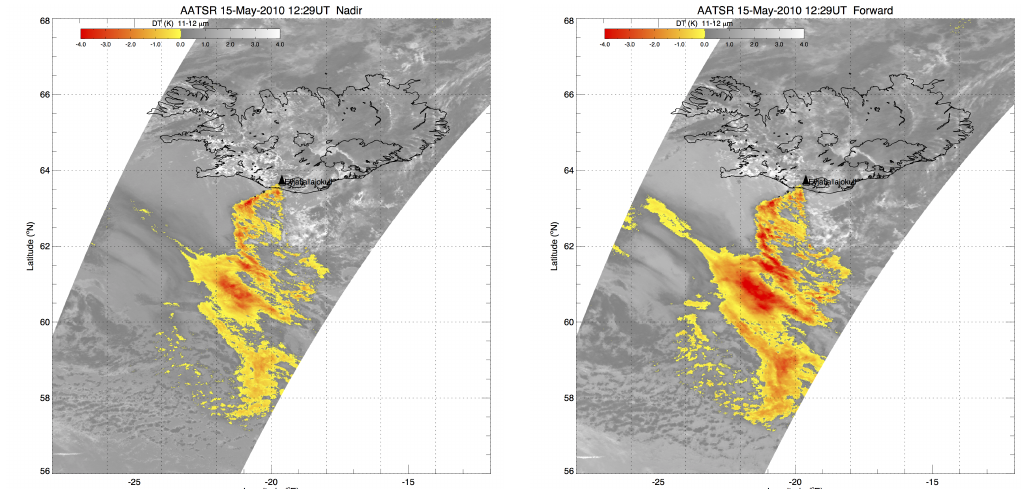
Figure 9. ( left-panel ) Nadir AATSR brightness temperature difference (brightness temperature difference BTD= T 11 − − T 12 µ m) image. Pixels with BTD < 0 K are coloured in shades of yellow to red. Images such as these are extremely useful for assessing the spatial extent and boundaries of ash clouds, but do not provide information on altitude. ( right-panel ) Forward view ( ∼ 55 ◦ ) obtained at the same time as the nadir view and scaled the same way. Note that the spatial extent of the ash is a little larger and the sensitivity is better, due to the more oblique view.